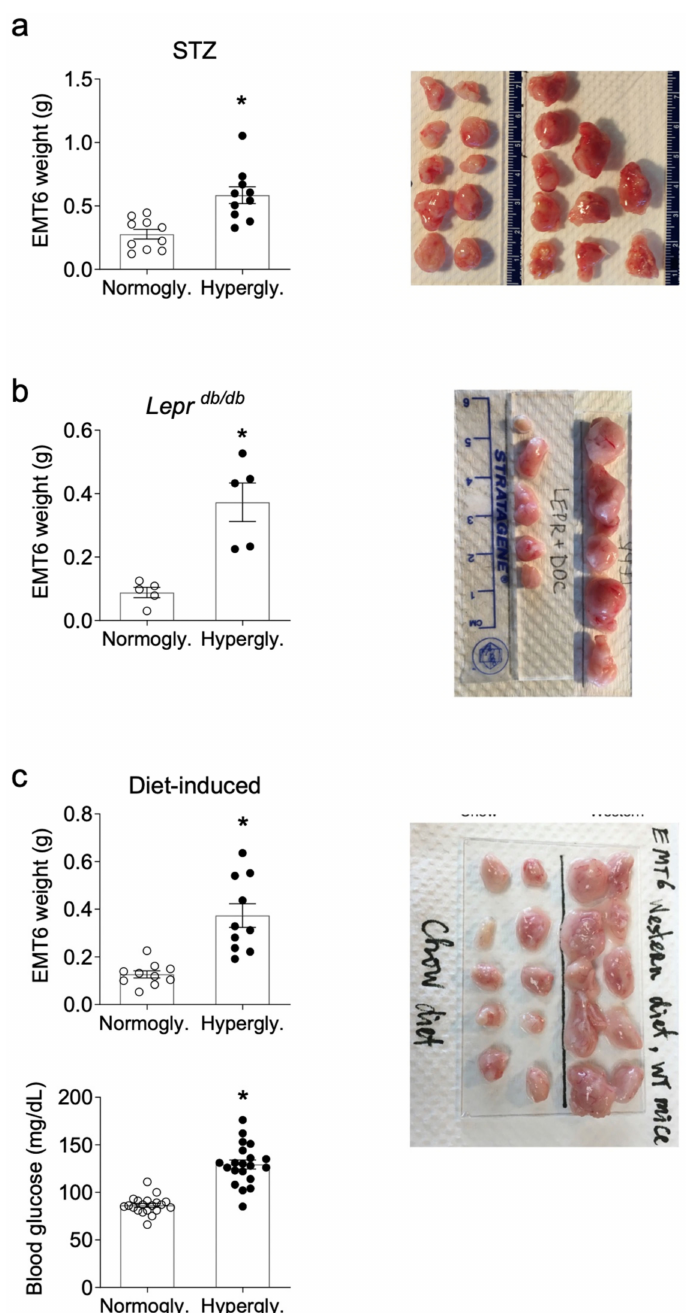
Figure 1. Increased EMT6 BC tumor weights in hyperglycemic mice. EMT6 cancer cells were injected subcutaneously into normoglycemic or hyperglycemic: ( a ) WT mice treated with STZ ( n = 10/group), ( b ) Lepr db/db mice ( n = 5/group), ( c ) WT mice on Western diet ( n = 10/group), as described in Methods. Fasting blood glucose levels were measured at end point. Tumors were excised a week later and weighed. Bars represent the mean ± SEM. * p <